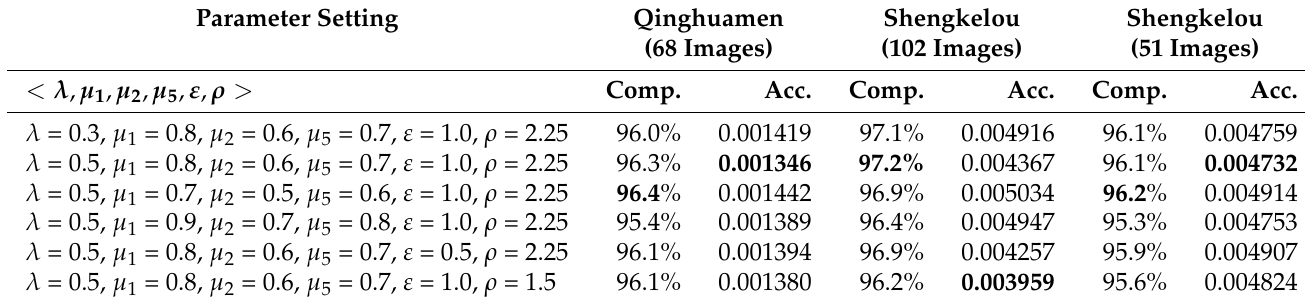
Table 4. Evaluation results of the parameters involved in the proposed metric on different datasets when τ = 50%. Bold number indicates the best result for each